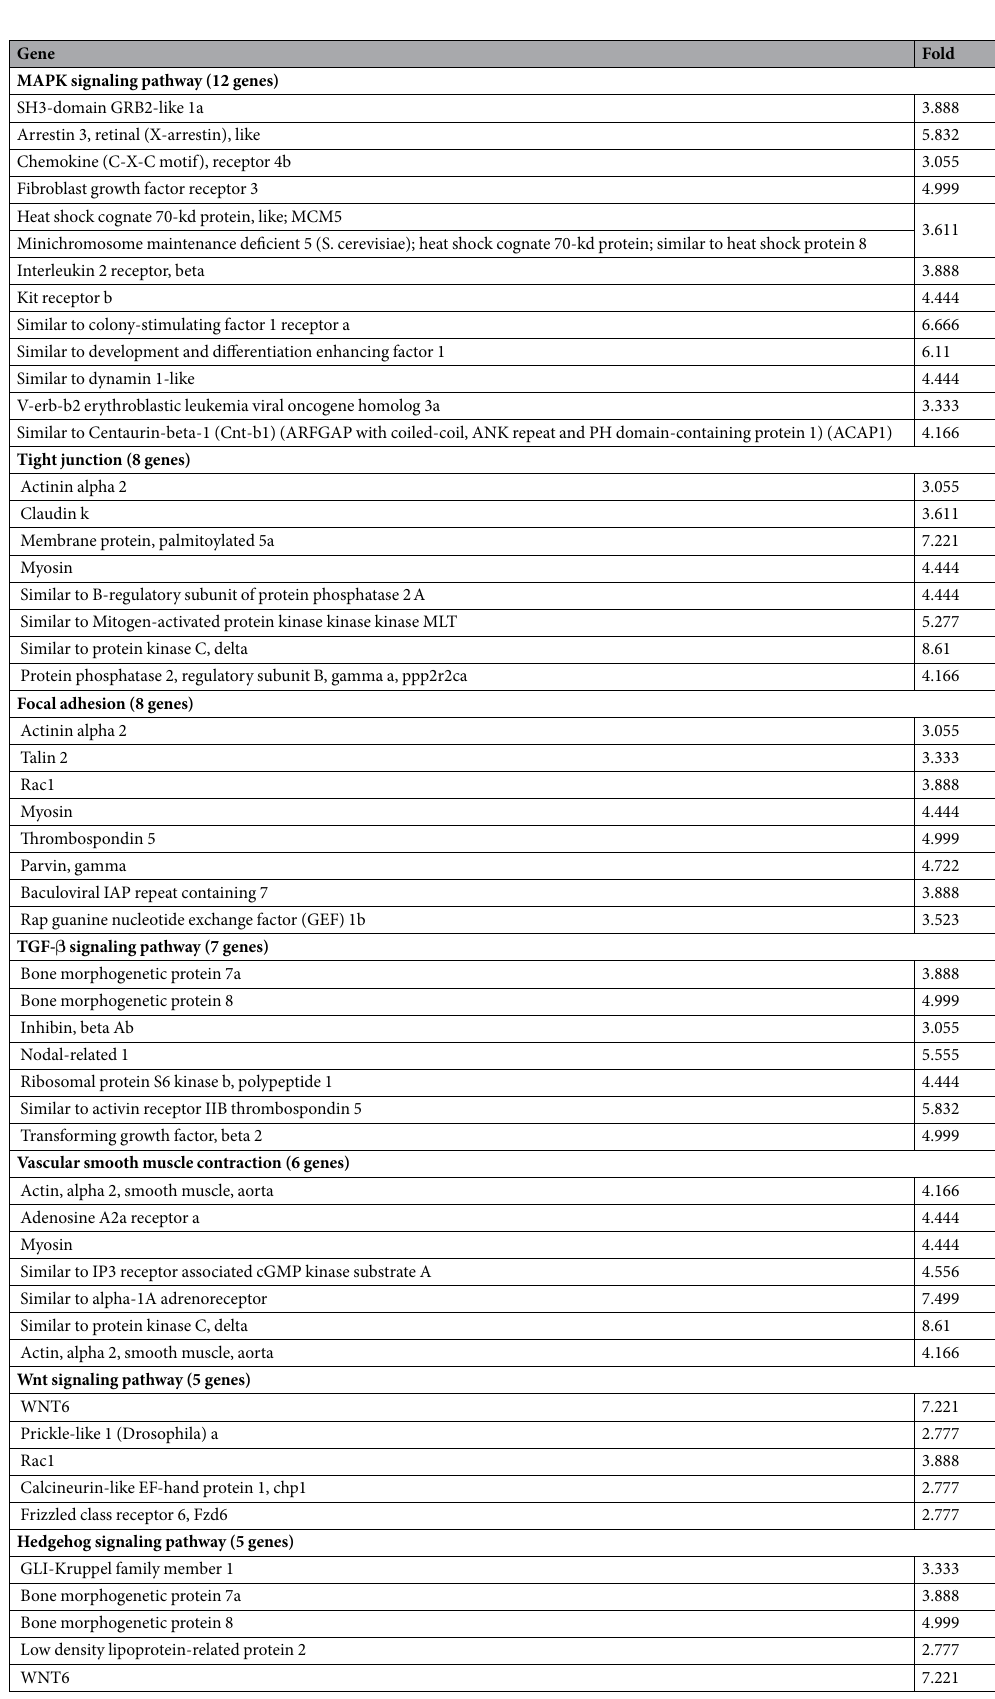
Table 3 . Observed differentially methylated genes (fold > 5) in S-( + )-fipronil treated group involved in seven developmental associated